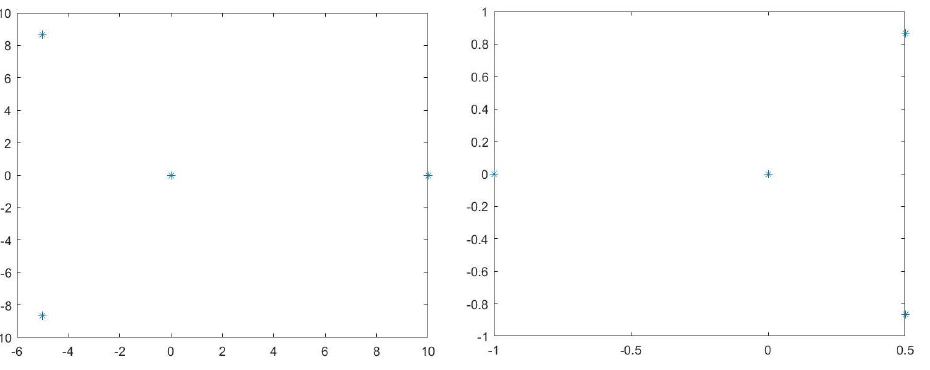
Figure 6. Idem for λ = − 1 ( left ) and λ = − 1000 ( right ). To this end, a = 1, with χ 1 → a and | x | δ (cid:101) = 1. It shall be noted that there exists at least one root Re ( s ) >